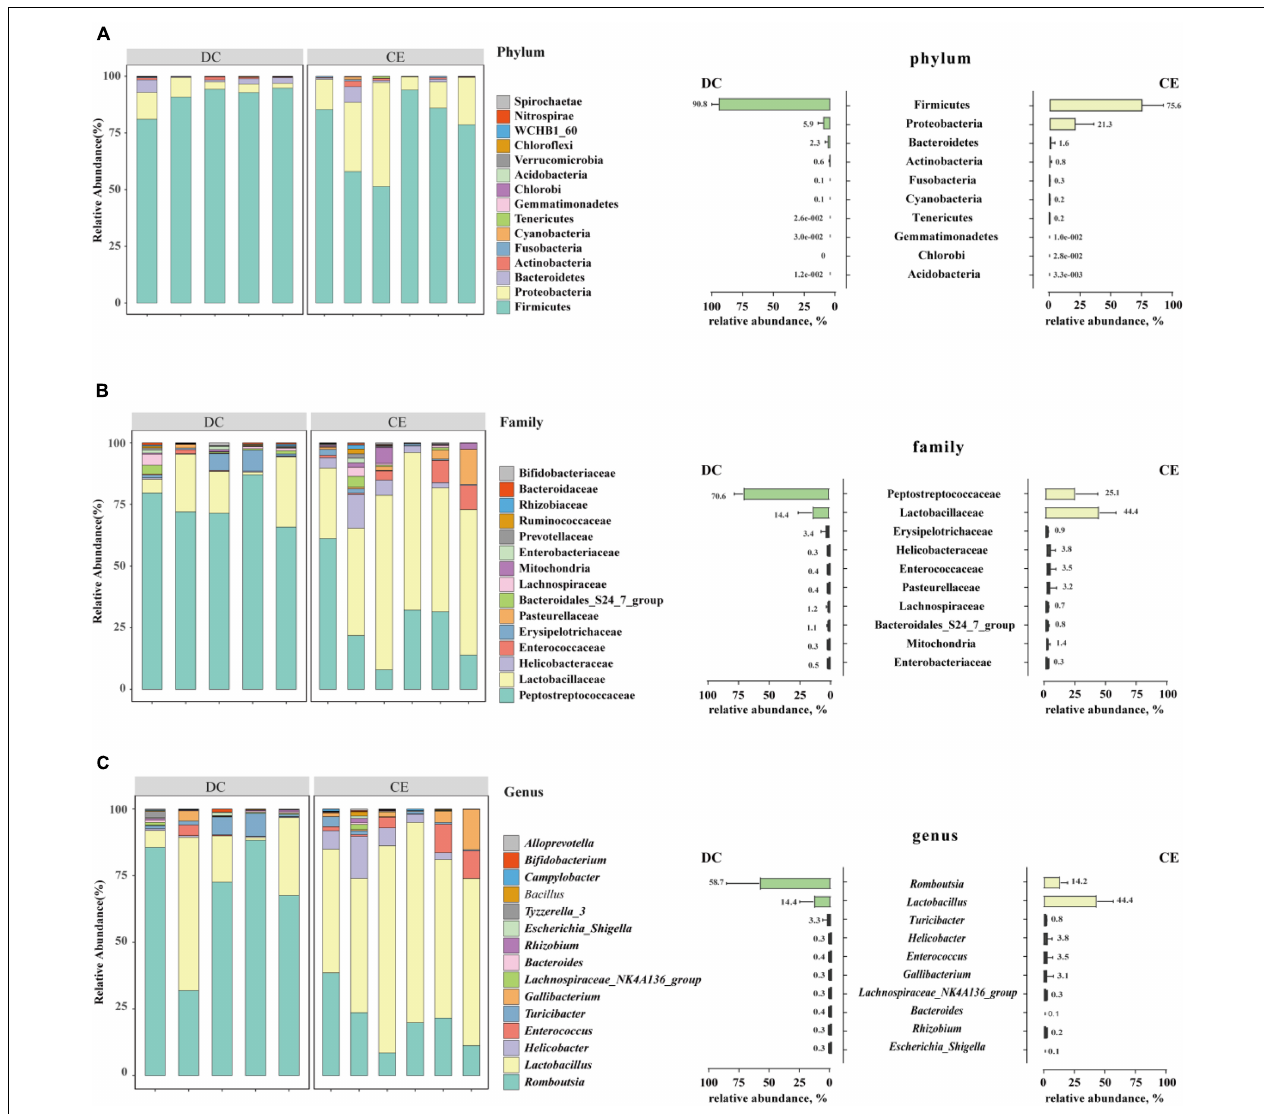
FIGURE 3 | The stacked graph of microbial community structure at (A) phylum level, (B) family level and (C) genus level ( n = 6 hens/group). The bar chart on the right represents the relative abundance distribution of TOP 10 bacteria at different taxonomic levels,